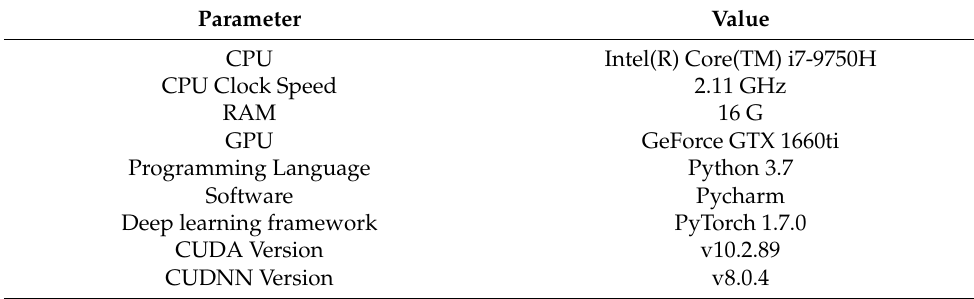
Table 1. Configuration information of the experimental environment.